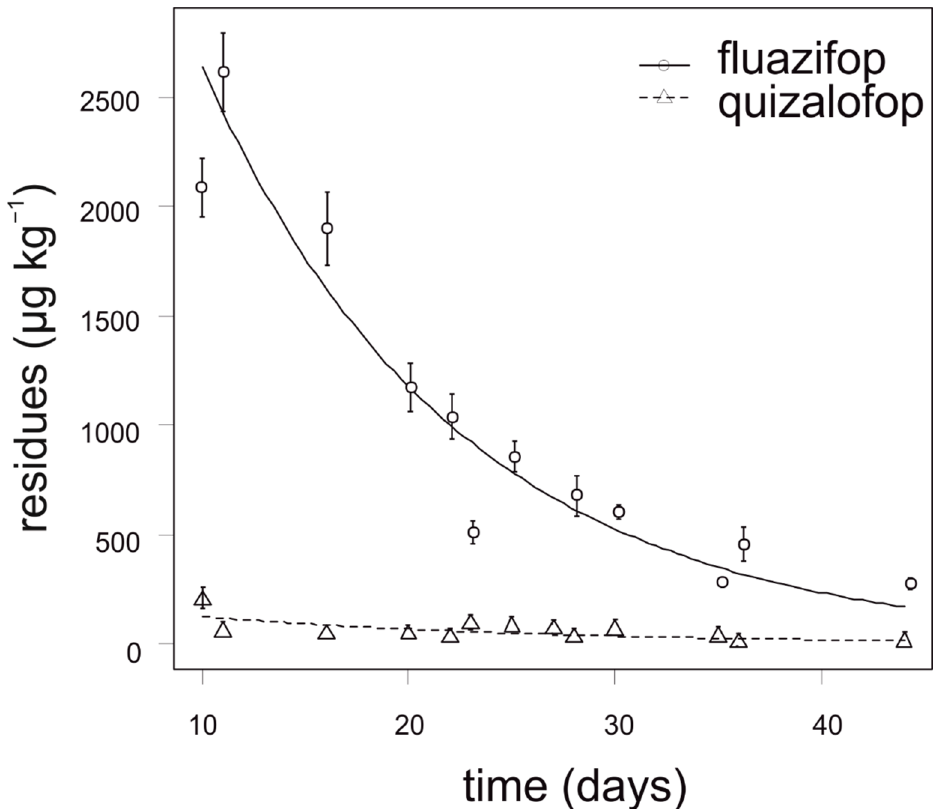
Figure 4. Degradation dynamics of fluazifop and quizalofop in cauliflower. Mean values with error bars representing standard error of the mean. Table 8. Hypothetical pre-harvest interval for different